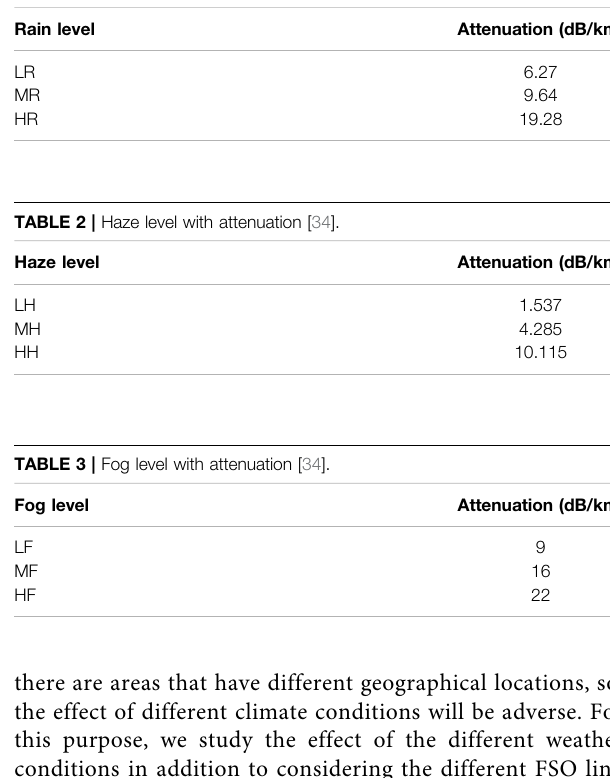
TABLE 1 | Rain level with attenuation [32].